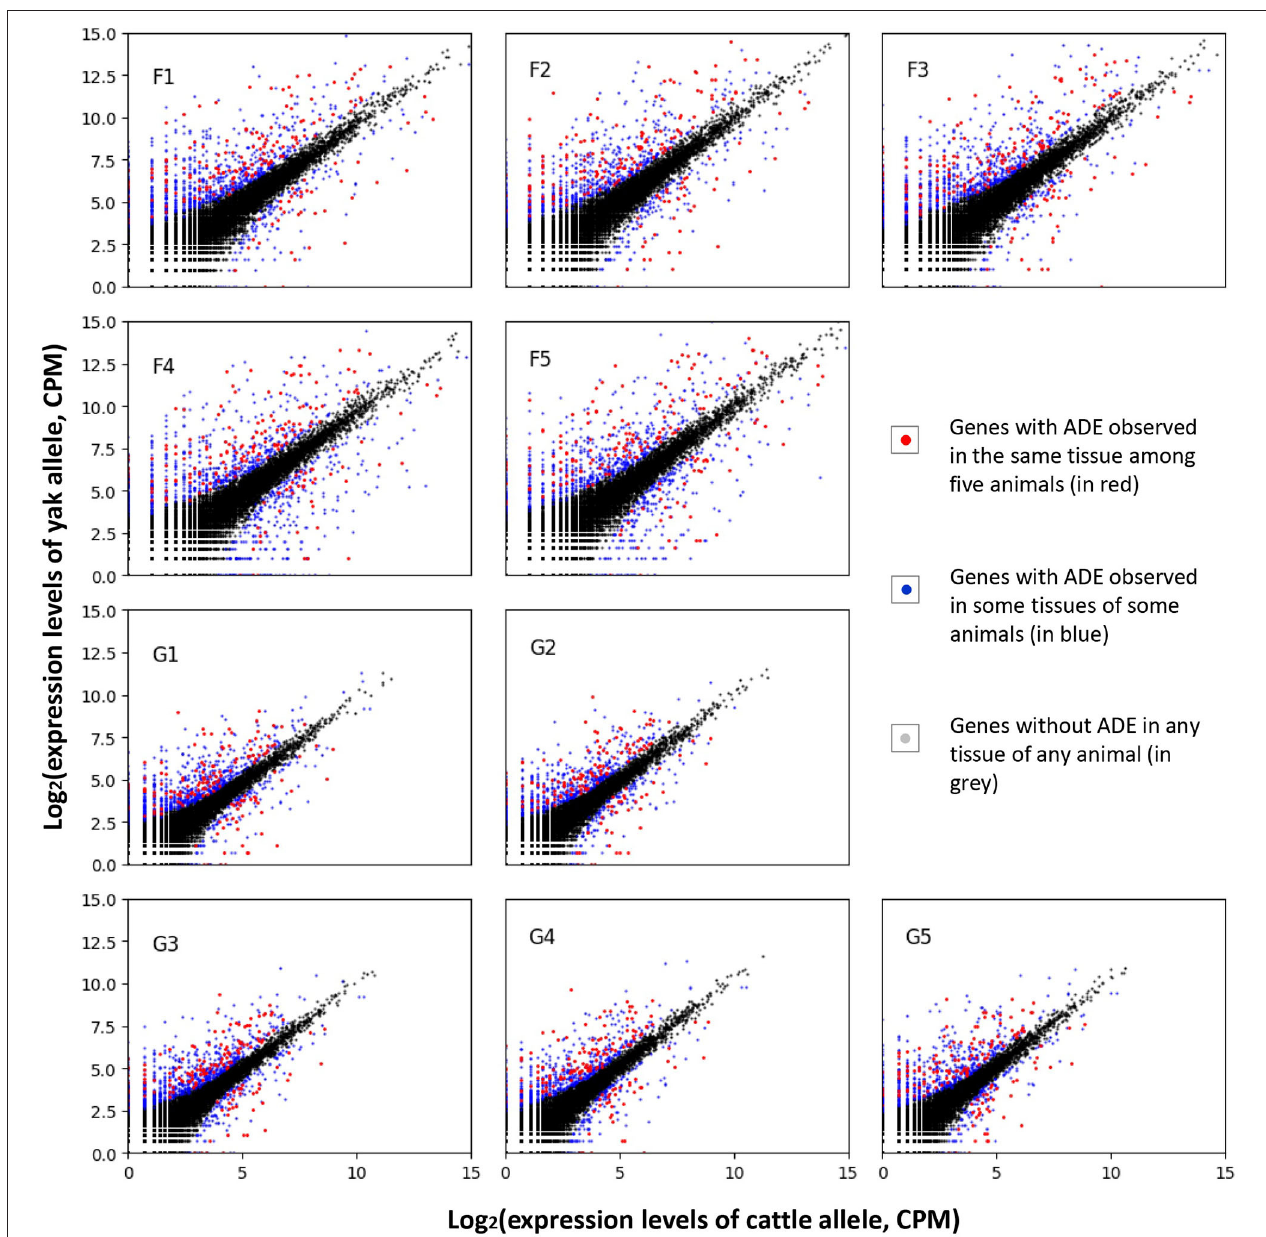
FIGURE 3 | Allelic differential expression among the sequenced samples. The sample names were denoted by prefix of “F” and “G” for lung and liver issues, respectively; such as, the “F1” denotes the sequenced lung issue for the first animal. CPM, counts per million mapped reads.